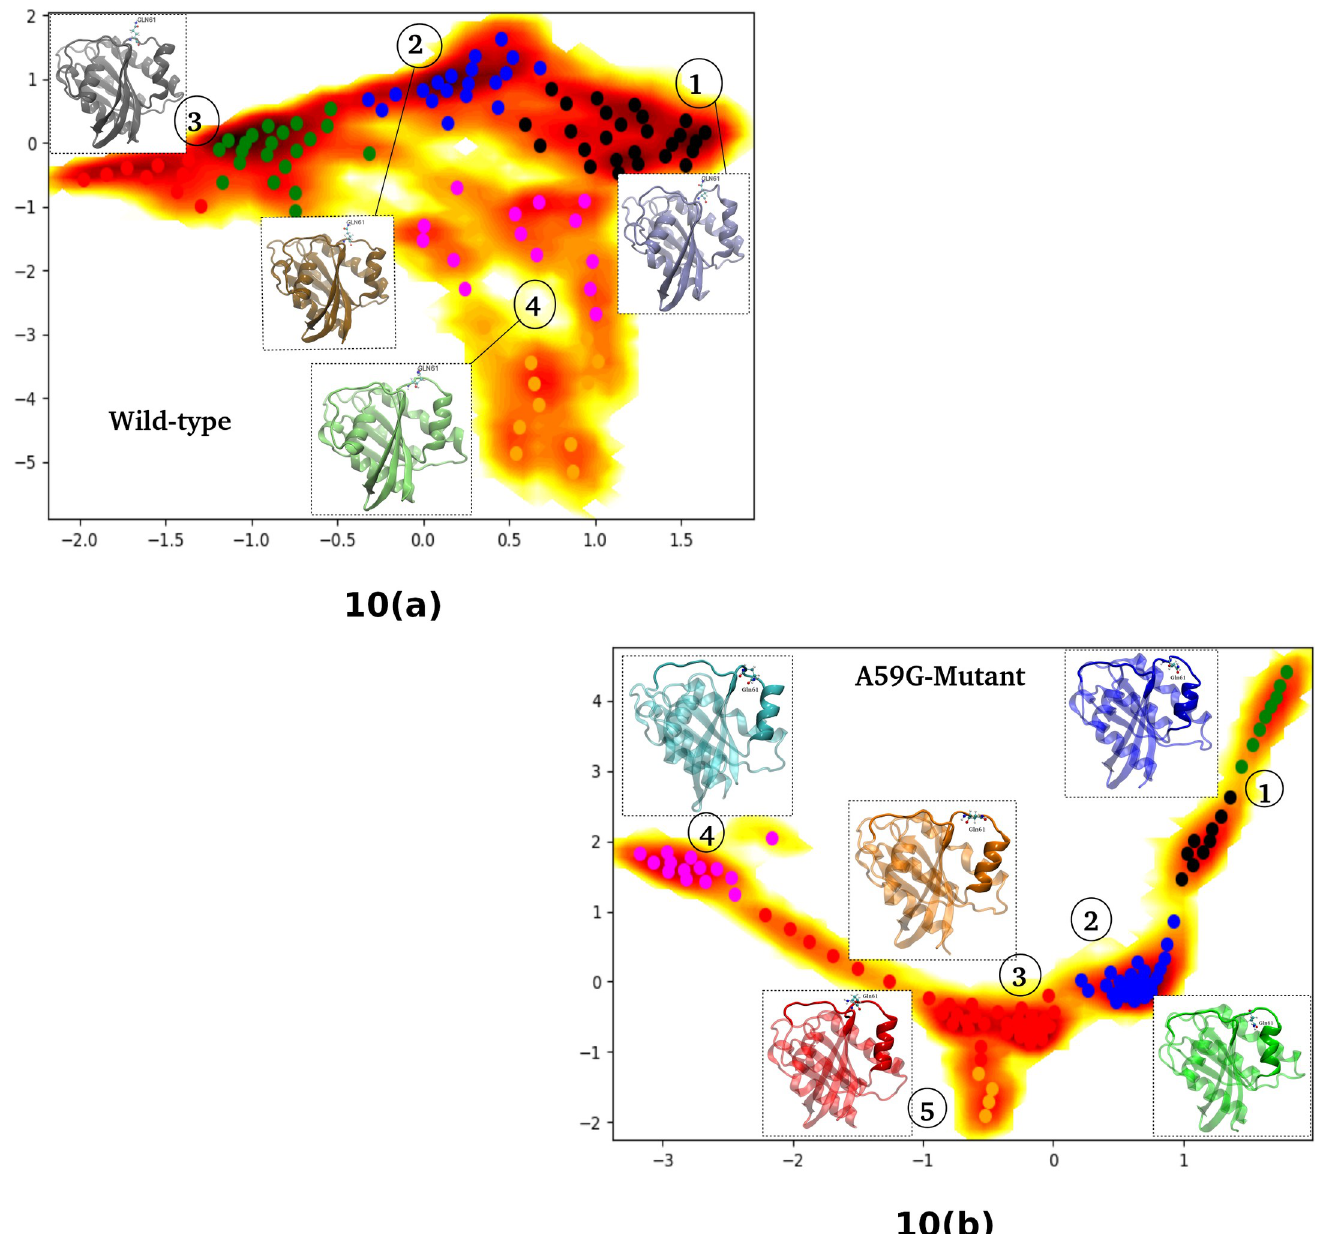
Fig 10. Depiction of metastable clusters for the wild-type and mutant trajectories, represented by numbers, as captured using PyEMMA while performing MSM based analysis. The feature used was Cadist (distances between the C-alpha atoms of the respective trajectories). https://doi.org/10.1371/journal.pone.0234836.g010 Furthermore, Fig 12 shows an overlap of the pre-hydrolysis network region of a mutant structure from the metastable state cluster 5 (yellow CPK representation) and the most stable conformations, each from wild-type simulation and mutant trajectories (cluster 1). This pre- hydrolysis state is difficult to encounter in the mutant simulations and in this 5 μ s mutant sim- ulation, the structure was observed for a short time as demonstrated by the sparsely populated cluster 5.